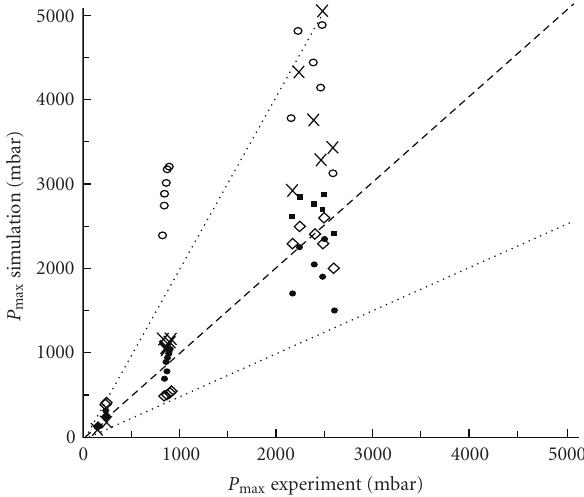
Figure 3: Comparison of experiment and simulation for MERGE large scale experiments ( × ) COBRA predictions, ( predictions, ( • ) FLACS predictions, and ( ◦ ) REAGAS predictions. Simulated maximum overpressure and experimental maximum overpressure [mBar],